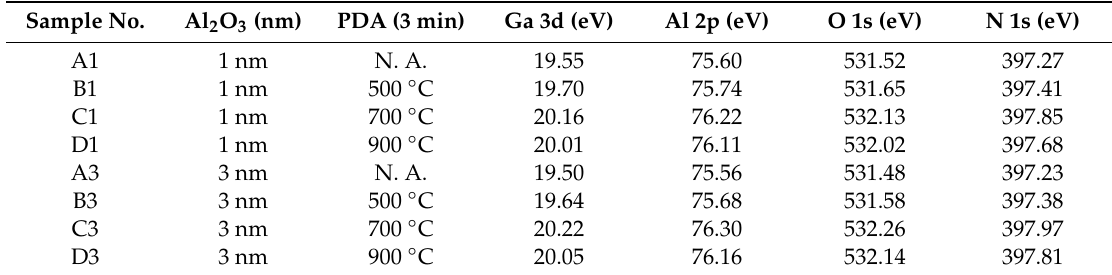
Table 1. Binding energies of core elements at Al 2 O 3 / GaN interfaces.